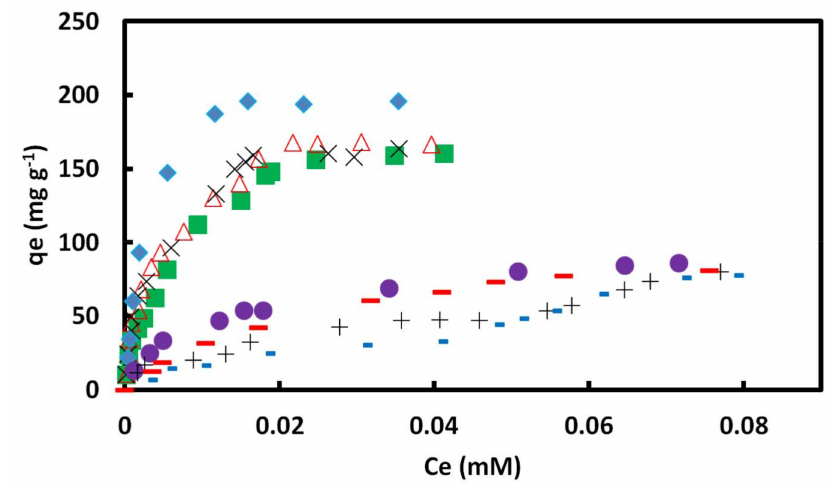
Figure 7. q e versus c e for adsorption of CR on GO/PAMAM nanocompositefrom 0.05 mM CR at (cid:4) 308, ∆ 318 and × 328 K in water and in (cid:7) 0.1 M NaCl, pH = 10, + pH = 11, − pH = 12 and pH = 13 solutions at 318